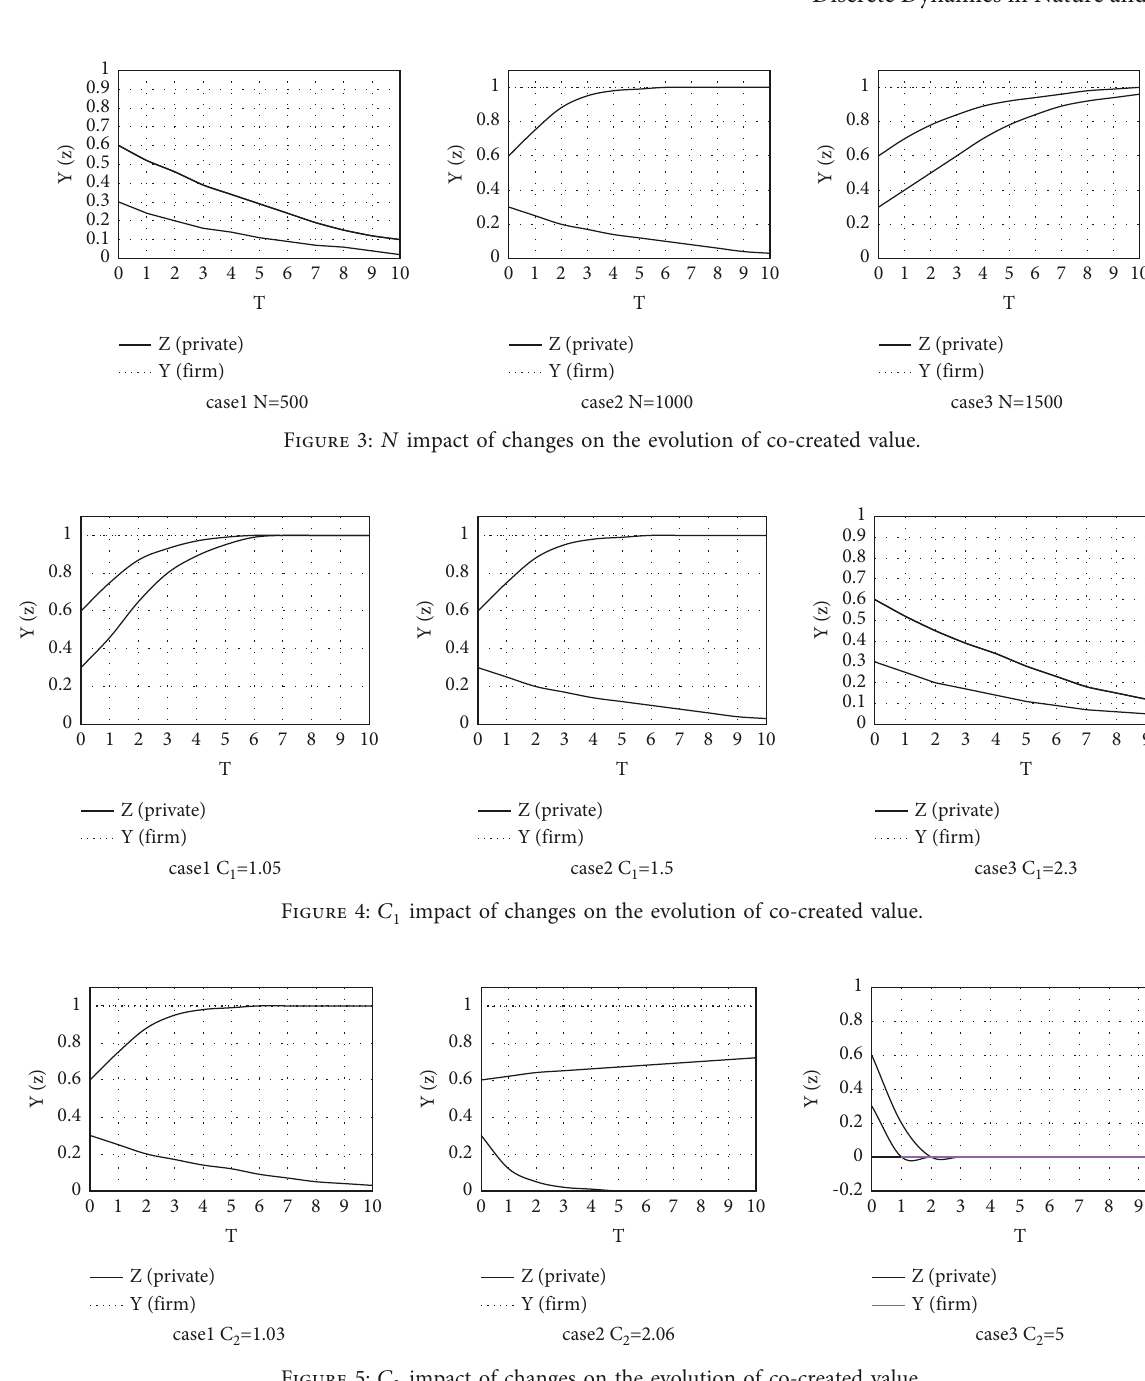
Figure 5: C 2 impact of changes on the evolution of co-created value.